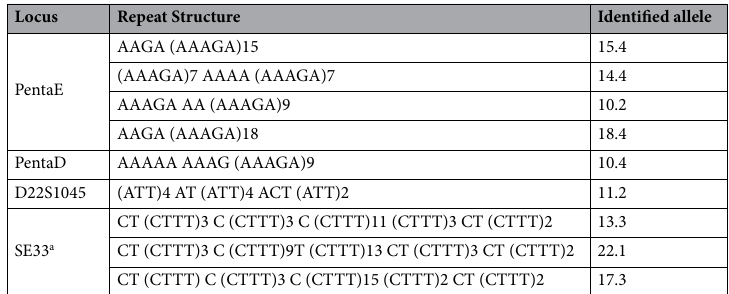
Table 2. Off-ladder alleles in the Kuwaiti population identified using sequencing data. a SE33 length allele designation according to Borsuk et al. 41 .